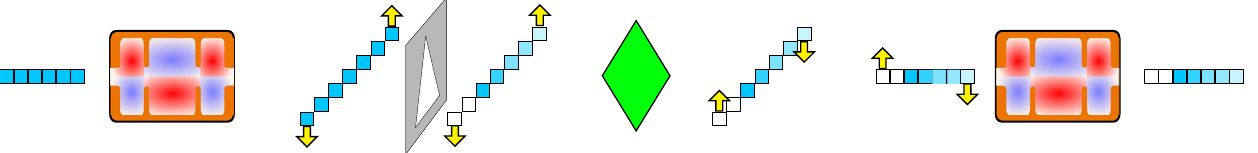
FIG. 1. Conceptual drawing to show the principle of TDC-based shaping. Rectangular boxes represent an electron bunch along the z direction. Colors correspond to electron density. Yellow arrows show the direction of horizontal momentum ( x 0